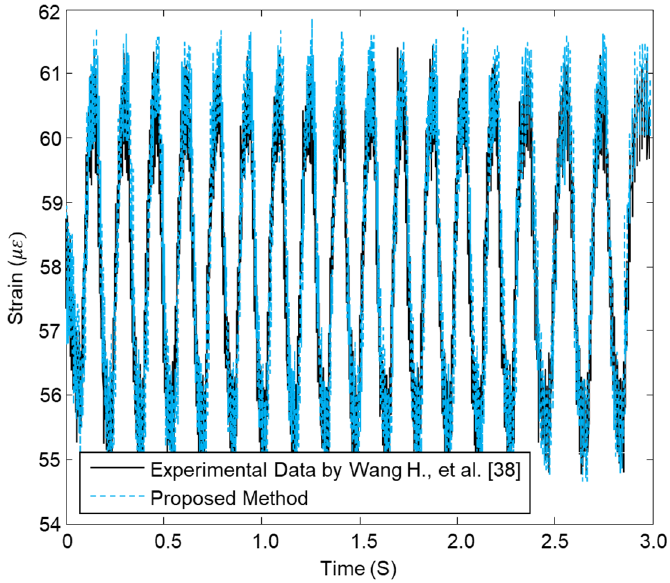
Figure 21. Comparison between the proposed method and experimental values of strain at 10 Hz for FBG2 in a CFRP composite pipe. FBG2 in a CFRP composite